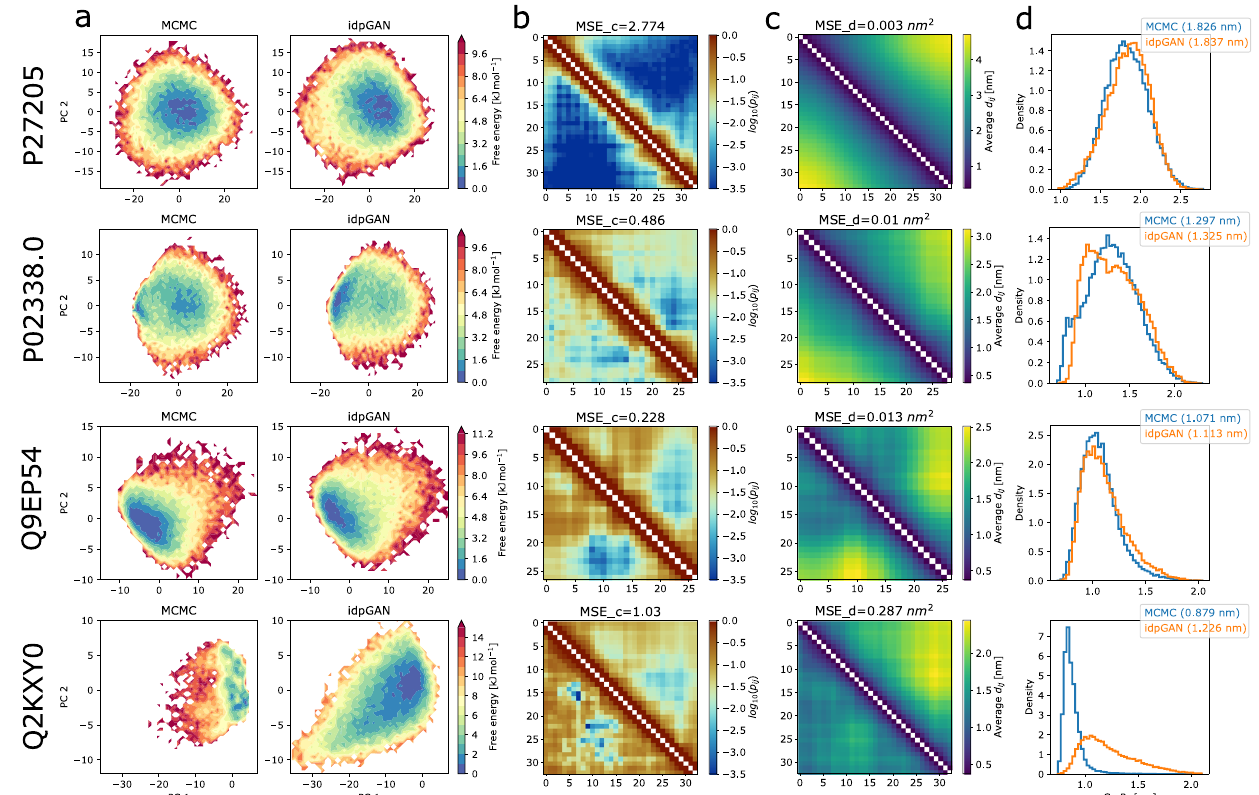
Fig.6|ExamplesfromidpGANforfourABS_testpeptides. Therowsoftheimage show data for P27205 ( L =34), P02338.0 ( L =29), Q9EP54 ( L =27) and Q2KXY0 ( L =33), respectively. For each peptide, the following information is reported: a potential of mean force pro fi les of MCMC (reference) and idpGAN ensembles in PCA space. For each peptide, the pro fi les were obtained as in Fig. 3 (see above). b C α contact map evaluation, idpGAN contact maps are shown in the upper